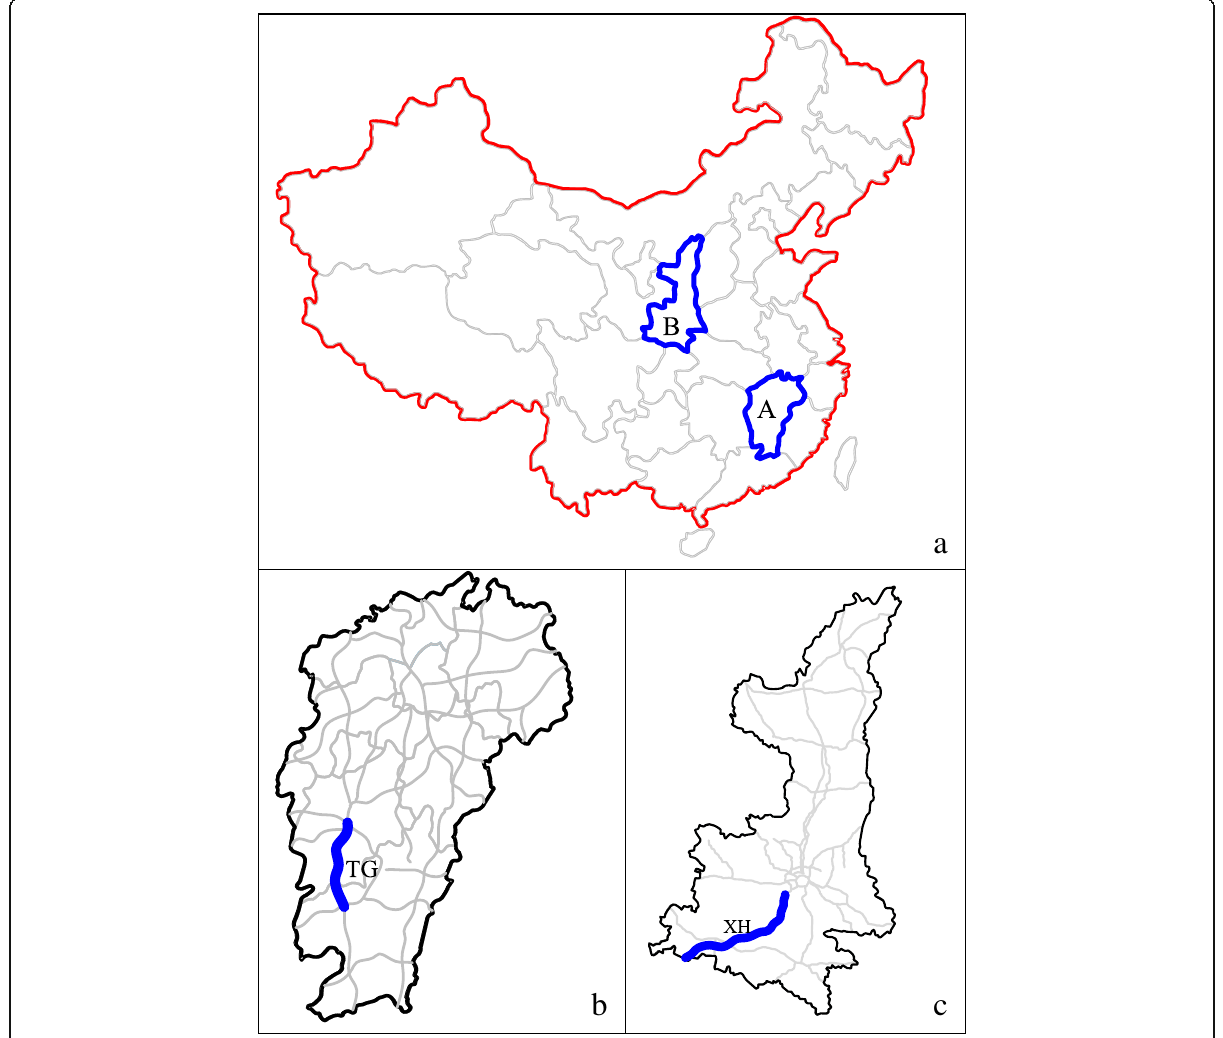
Fig. 1 Two mountainous freeway segments in Jiangxi and Shaanxi, China. a location of Jiangxi (A) and Shaanxi (B) in China mainland; b TG Freeway: a segment of Daguang Freeway G45 from Taihe Hub to Ganzhou Hub (K2916 + 390~K3044 + 169) in Jiangxi, China; c XH Freeway: a segment of Jingkun Freeway G5 from Hechizhai Interchange to Qipanguan Tunnel (K1102 + 608~K1463+ 451) in Shaanxi,